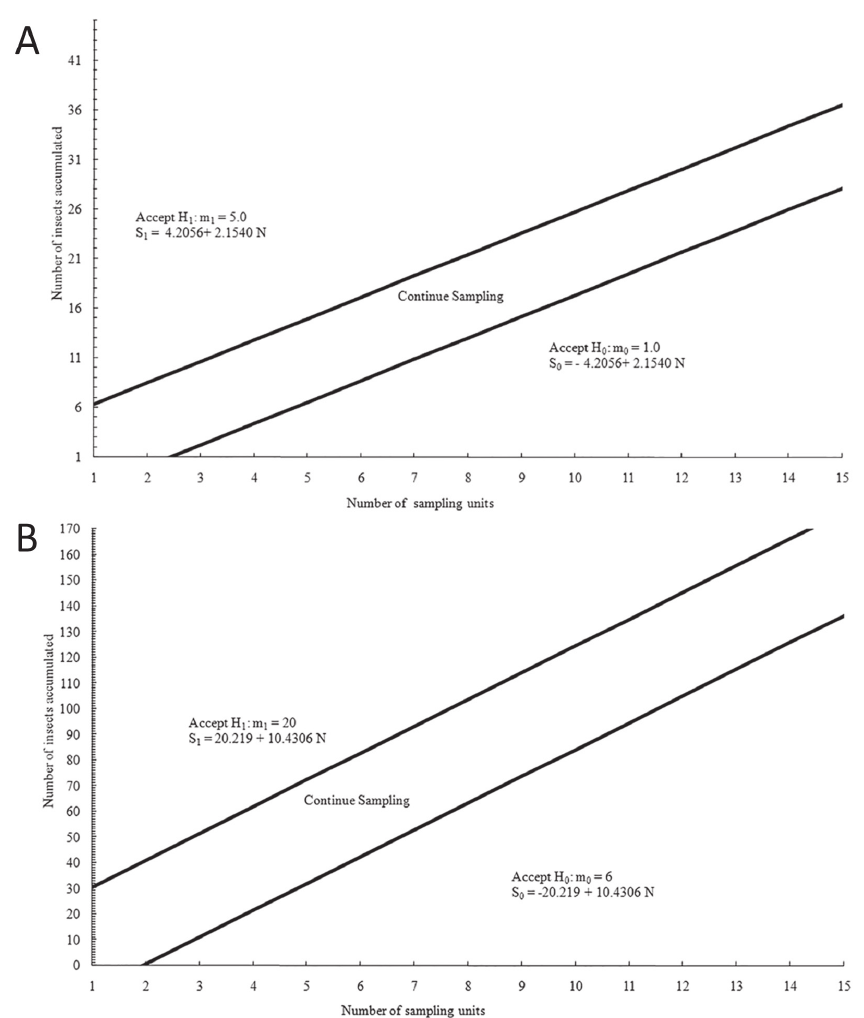
Figure 1 - Stop sampling lines for classification-based binomial sequencial sampling for adults of Bemisia tuberculata (Hemiptera: Aleyrodidae) to the biological (A) and chemical (B) method